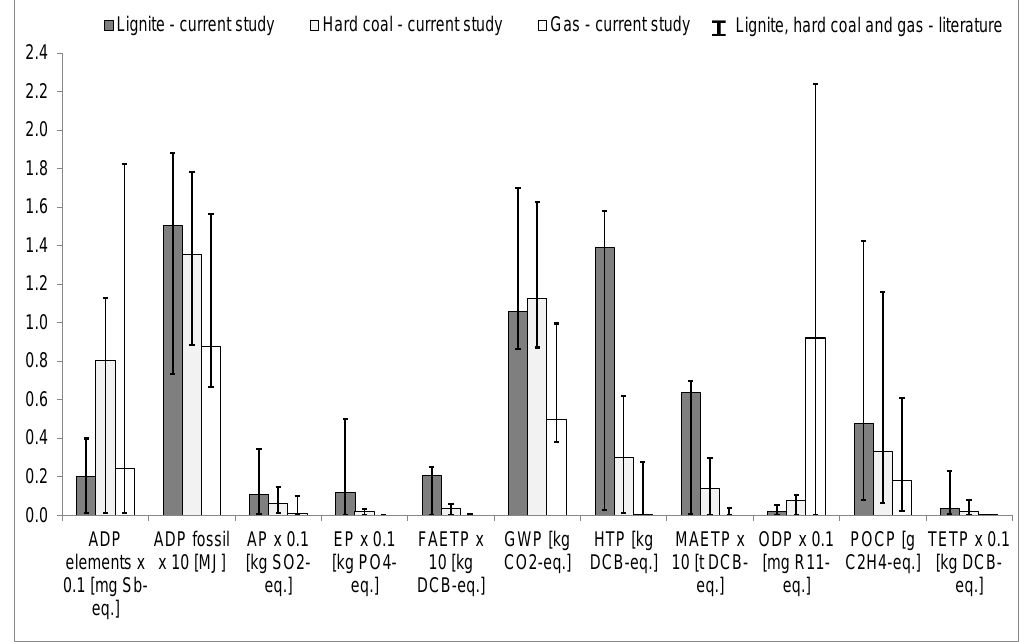
Figure 4. Comparison of the results from current study with literature for coal and gas. [All impacts expressed per kWh of electricity generated. Literature data for lignite from [15], [19], [21] and [43]; for hard coal from [19], [27] and [43]; for natural gas from [14], [15], [19], [24], [27] and [43]. All impacts estimated using the CML 2001 method. For impacts nomenclature, see Figure 3.].